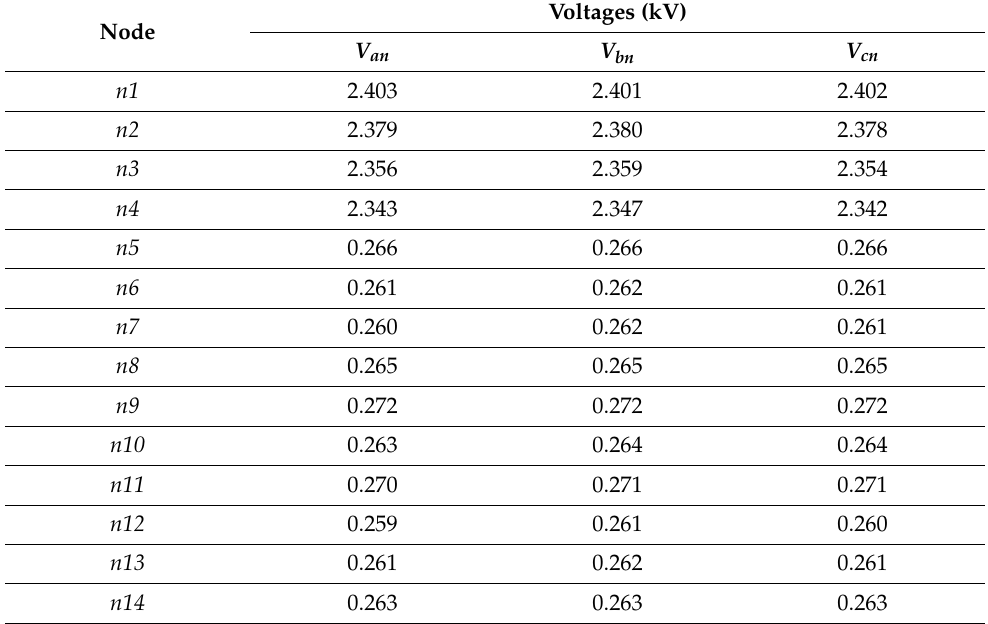
Table 1. Line-to-ground nodal voltage magnitudes for the base